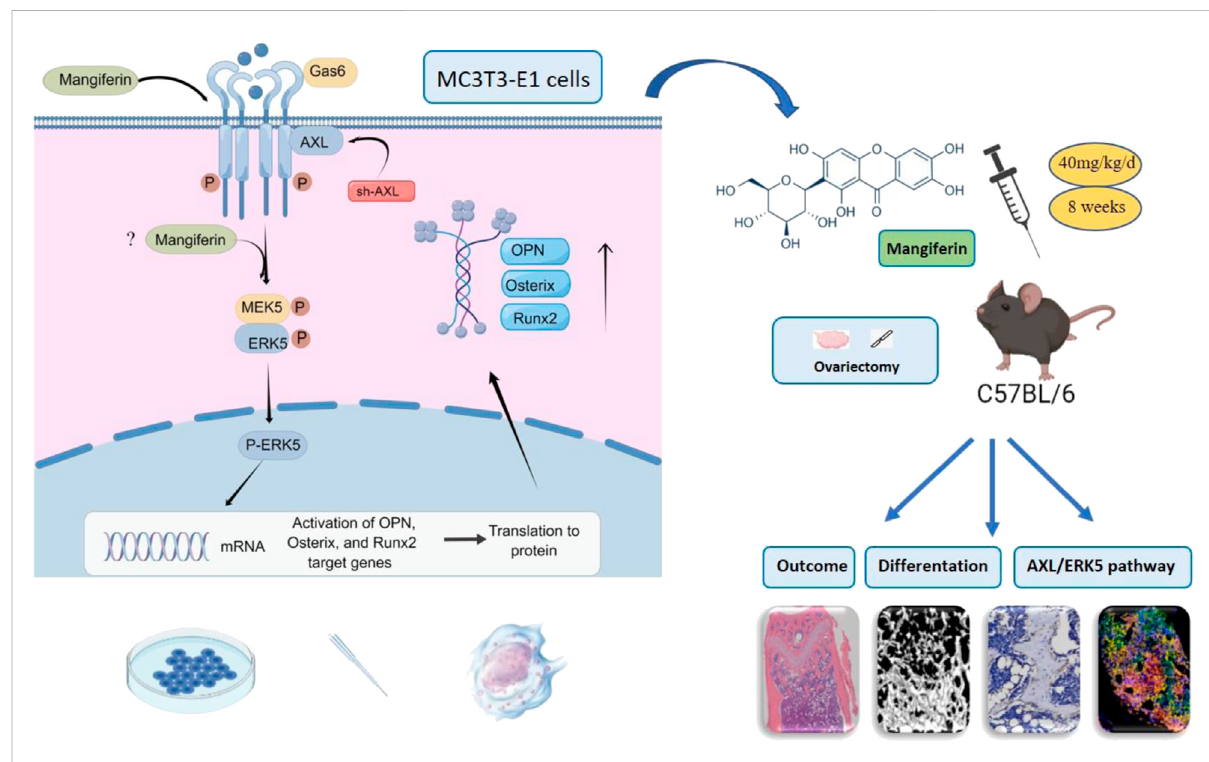
FIGURE 11 Mangiferin promoted osteogenic differentiation of MC3T3-E1 cells and alleviated osteoporosis in OVX mice. The potential mechanism was via the AXL/ERK5